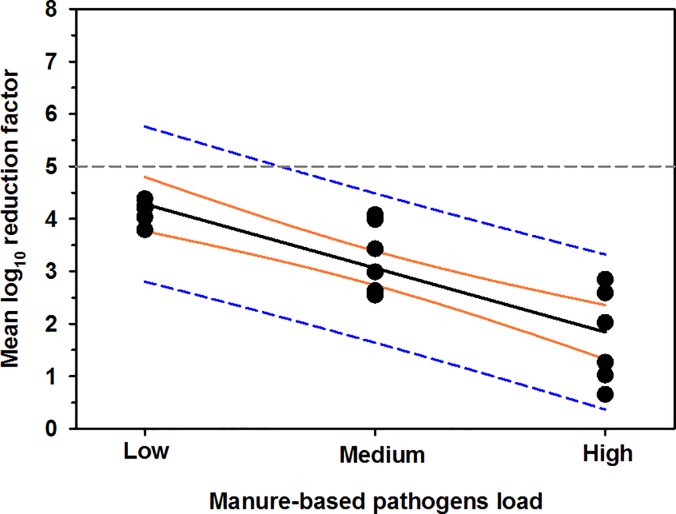
Negative linear relationship between the bacterial load and rate of bacterial reduction on nylon surface.The horizontal gray dotted line represent the safe level of MBP (>5-log10). The thick solid black line is the regression line, the orange lines are the 95% confidence interval for regression line, and the blue dashed lines are the 95% confidence interval for prediction.